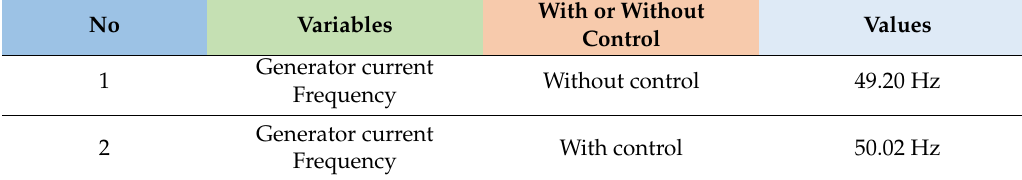
Table 3. Frequency